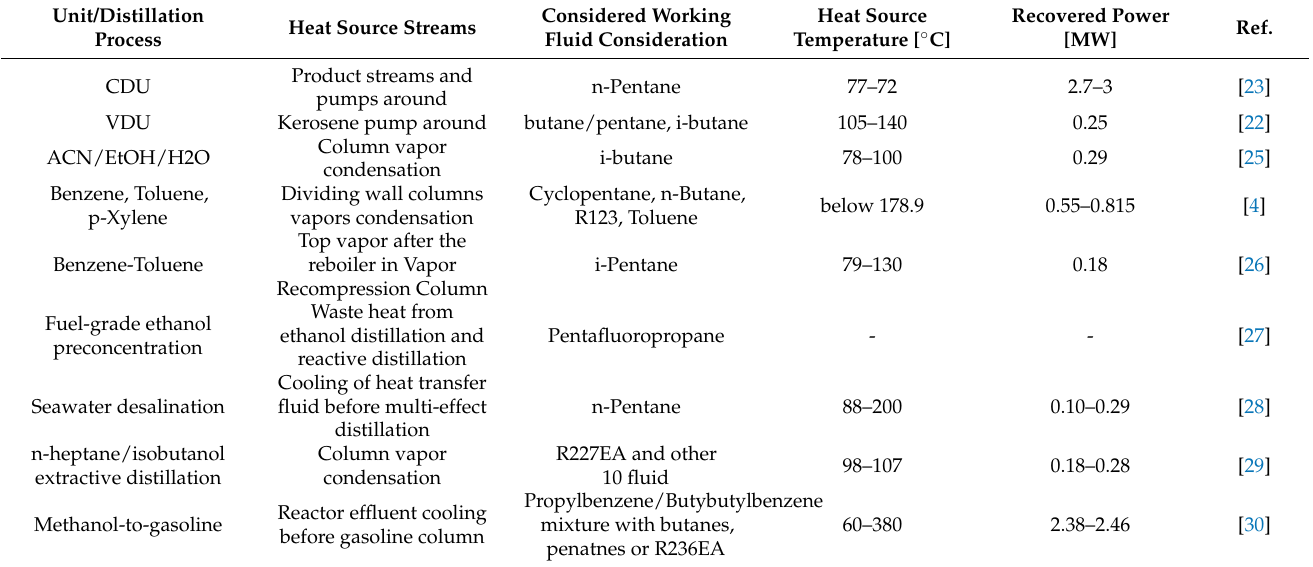
Table 2. Integration of ORC with distillation and related processes.